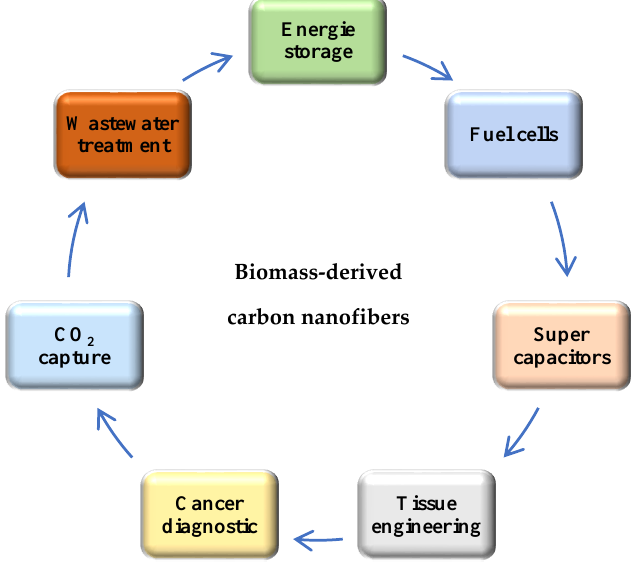
Figure 4. The different applications of biomass-derived carbon nanofibers.